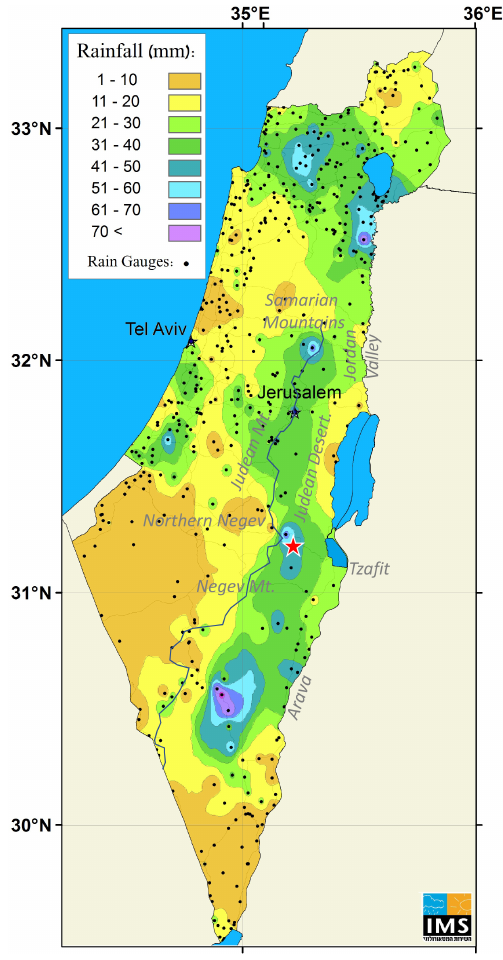
Figure 1. Rainfall distribution over Israel for the period of 25 April 06:00UTC to 27 April 06:00UTC 2018 from the IMS radar and rain-gauge measurements based on the INCA system integration method (Haiden et al., 2011). The black line indicates the water divide of the Samarian, Judean and Negev